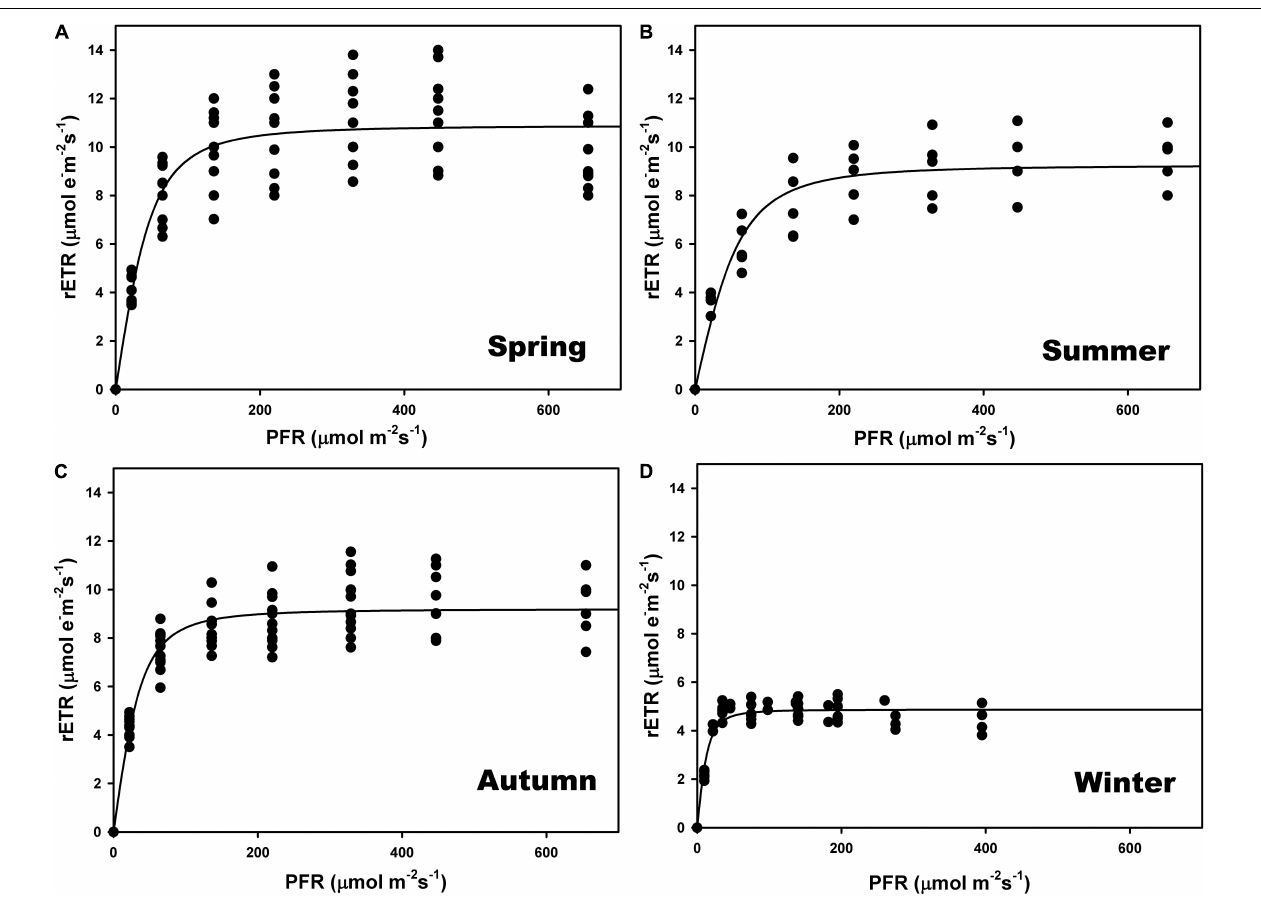
FIGURE 3 | Seasonal rapid light curves (RLC) during spring (A) , summer (B) , autumn (C) , and winter (D) . Data generated in situ at a maërl bed of Phymatolithon lusitanicum ( ∼ 22-m depth) using a Diving PAM fluorometer. Curves represent the adjustment of the model equation of Smith (1936) and Talling (1957) to the observed values ( n =